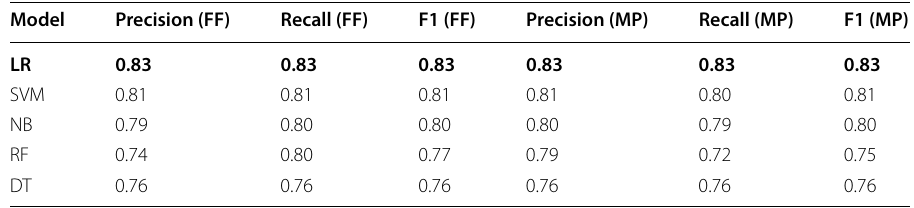
The Logistic Regression performs better than the other models with an average group accuracy equals to 83%